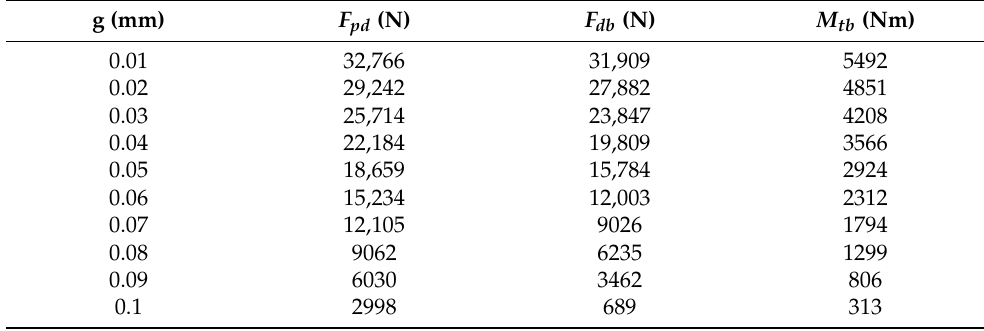
Table 2. Forces at the interfaces as a function of the gap (p= 4